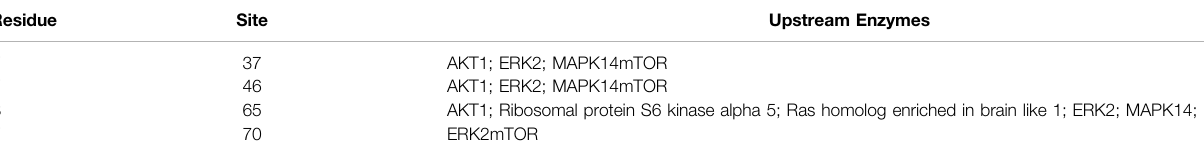
TABLE 2 | Key upstream kinases at different phosphorylation sites of 4EBP1. Residue